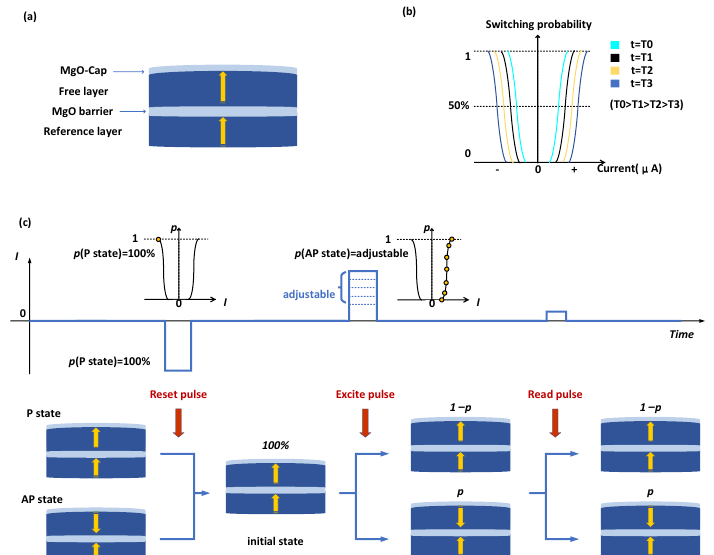
Figure 1. ( a ) Diagrammatic representation of the Double-MTJ employed in this investigation. ( b ) Switching probability of Double-MTJ under various current and pulse duration conditions. ( c ) Pro- cess of operation. Pulses for reset, excite, and read are applied in that